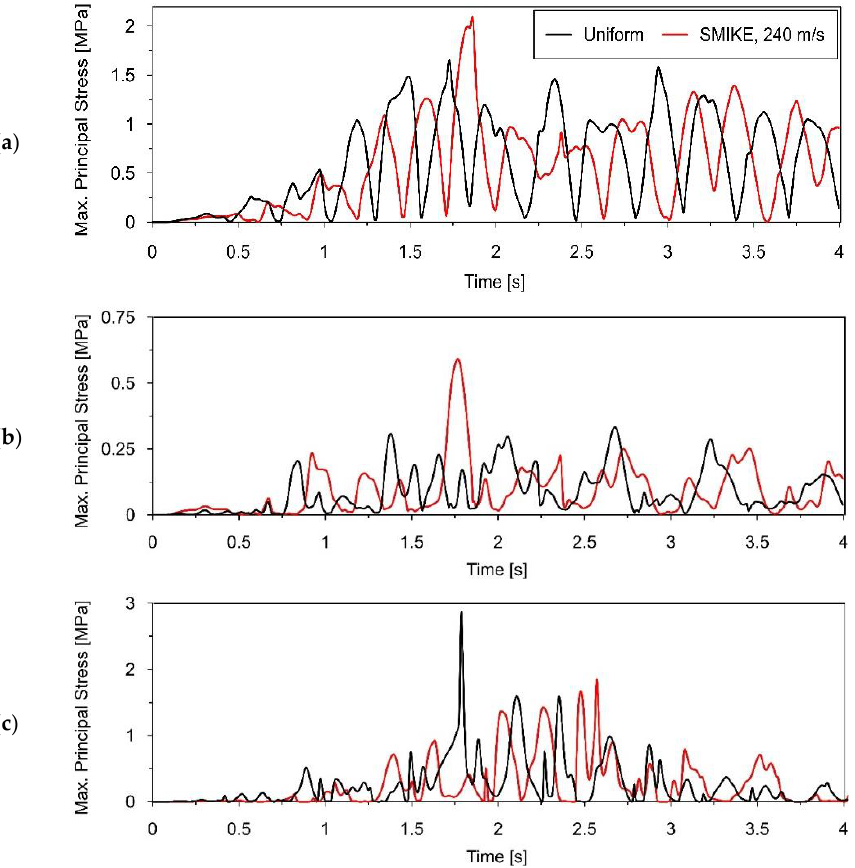
Figure 16. Time-stress histories obtained for the SMIKE model with the empirical parameters v = 240 m/s and α = 7 (red line) and for the classic Uniform Model of Excitation (black line) at representative points: ( a ) C1 (over the first column), ( b ) S2 (in the middle of the second span), ( c ) L3 (in the middle of the third